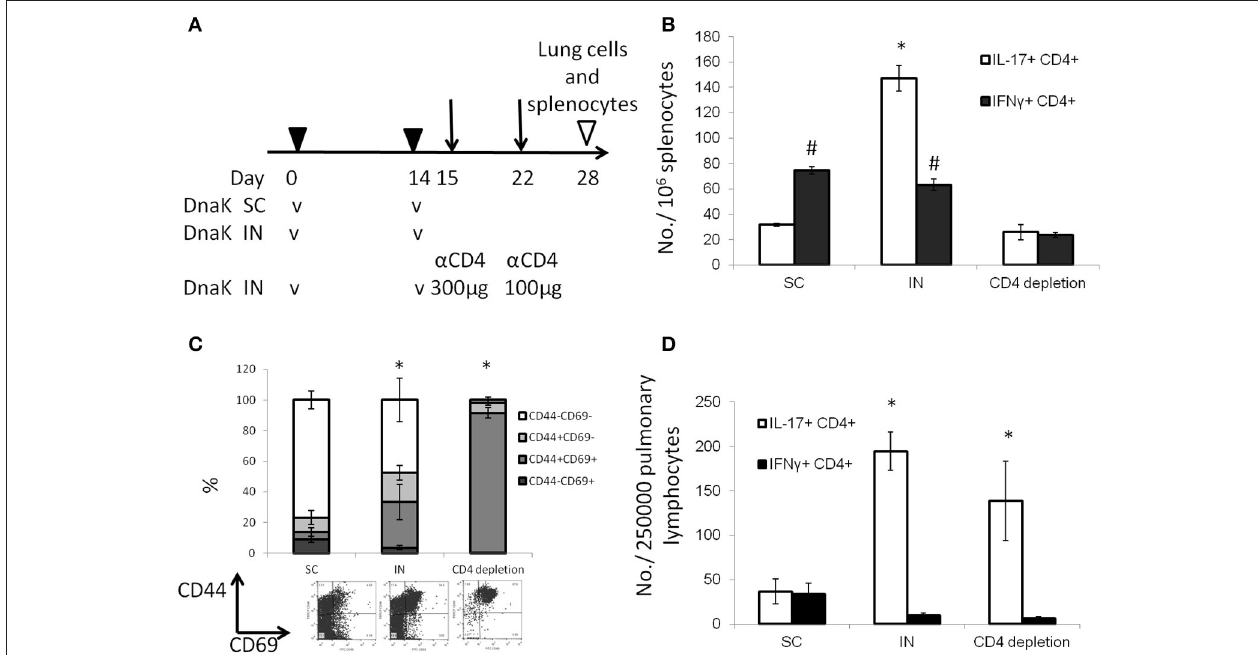
FIGURE 3 | Intranasal vaccination with DnaK generates tissue-resident T cells. C57BL/6J mice were vaccinated twice two weeks apart with DnaK (100 µ g) by subcutaneous injection or DnaK (20 µ g) by intranasal injection. One group of intranasally vaccinated mice received intraperitoneal injection of anti-CD4 + neutralizing antibody (300 µ g) 1 day after vaccination and another dose (100 µ g) 1 week later. Parenchymal T cells were analyzed 2 weeks after the last vaccine dose. (A) Experiment scheme. (B) Splenocytes were stimulated with DnaK protein (10 µ g/ml) and antigen-specific CD4 + T cells were assessed for IFN γ and IL-17 secretion by intracellular cytokine staining. Mean ± SEM, N = 3–4, * p < 0.05 compared to the other two groups, #p < 0.05 compared to CD4 + depletion mice. (C) After tissue digestion, unstimulated intrapulmonary CD69 + CD44 + CD4 + T cells were measured by flow cytometry. Mean ± SEM, N = 3–4, * p < 0.05 compared to the other